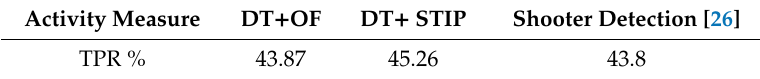
Table 4. True positive rates for active player detection in basketball event detection scenes.